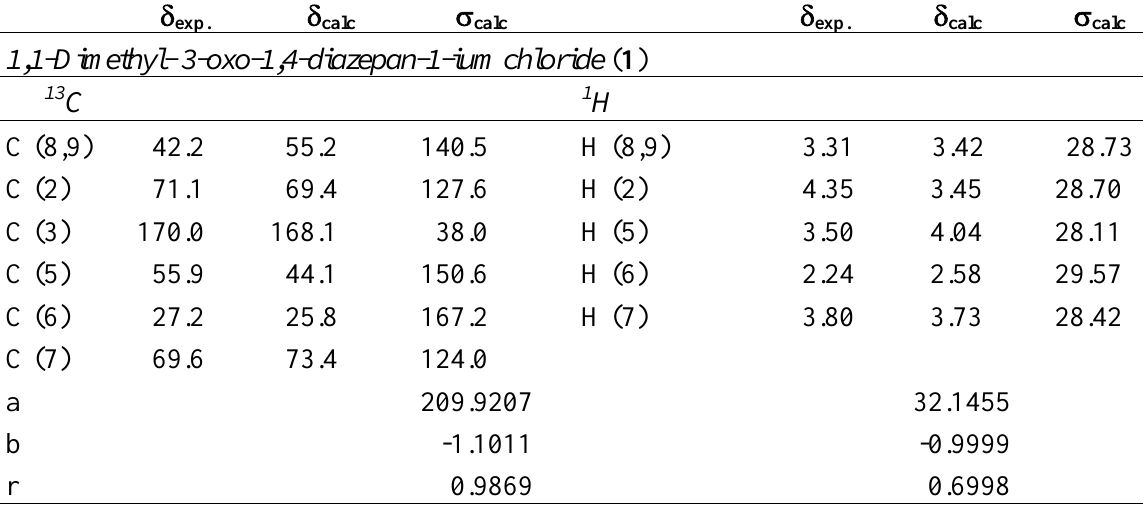
O calculating GIAO nuclear magnetic shielding Table 2 . Chemical shifts ( δ , ppm) in D 2 tensors ( σ ) for 1,1-dimethyl- 3-oxo-1,4-diazepan-1-ium chloride ( 1 ) and calc